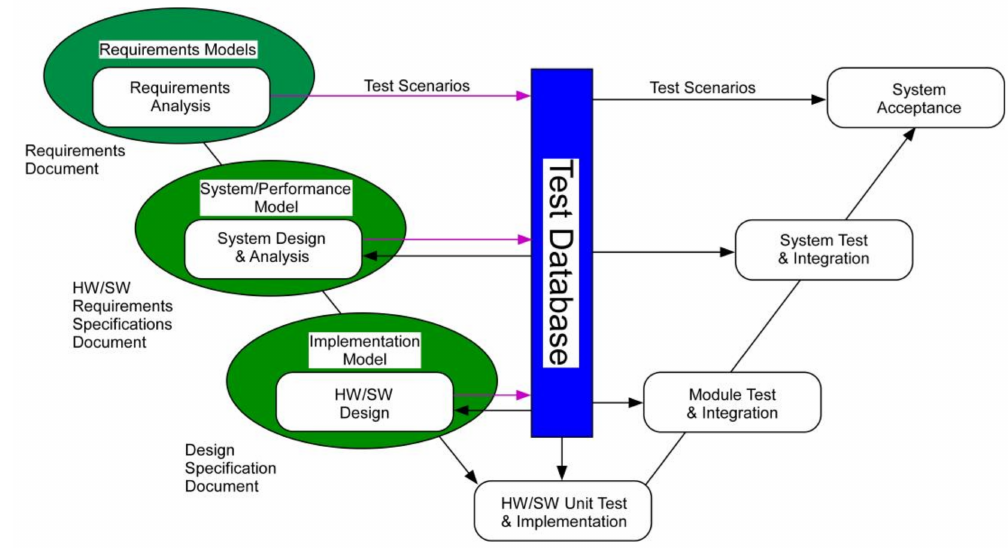
Figure 1. V-model